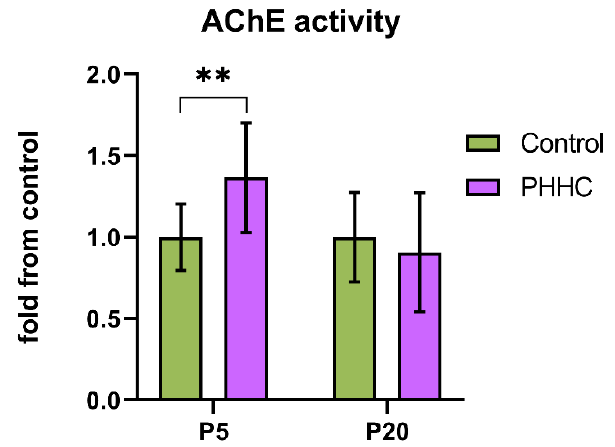
Figure 5. Effect of prenatal hyperhomocysteinemia (PHHC) on acetylcholinesterase activity in the hippocampus of the rat pups on P5 and P20. Data for each age are normalized to the appropriate control group for comparison and presented as mean ± SD, n = 10–19 for the control group, n = 9–19 for the PHHC group of animals performed in triplicate for activity. Significance of difference between the PHHC and control groups were determined by the Student’s t -test (** p ≤ 0.01).